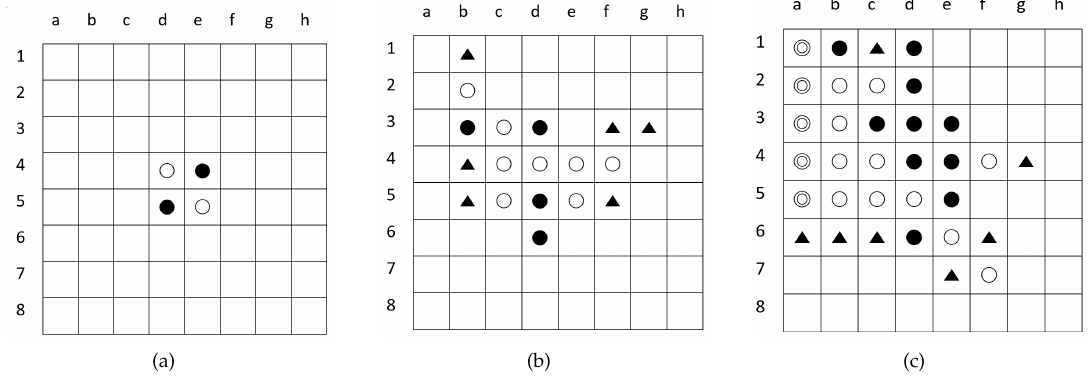
Figure 3. Illustration of Othello with an 8 × 8 board. ( a ) initial position; ( b ) After eight moves, black is to play. The triangle marked the black player’s mobility of six (six move options); ( c ) After 22 moves, black is to play. The triangle marked the black player’s mobility of seven (seven position options), and the white disks with marked inner circles are the stable disks (cannot be captured by the black